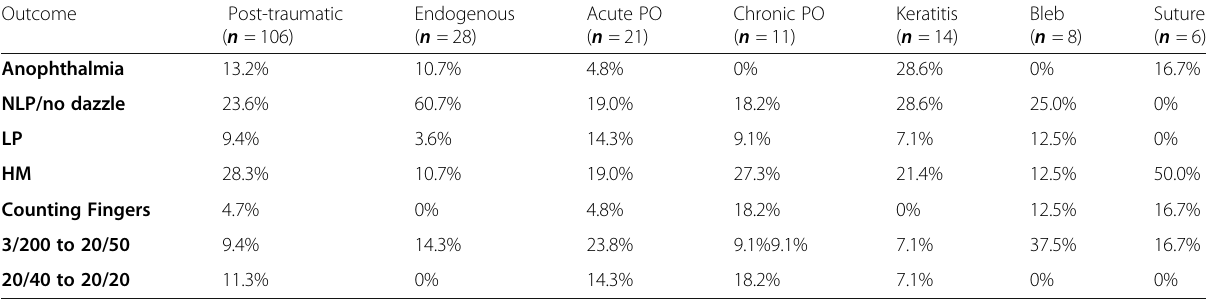
Table 4 Final BCVA among the different groups ( n = 194), excluding eight pre-verbal children with vision better than NLP or no dazzle. The acute post-operative and bleb-associated groups had the best outcomes, while the endogenous and keratitis groups had the worst outcomes